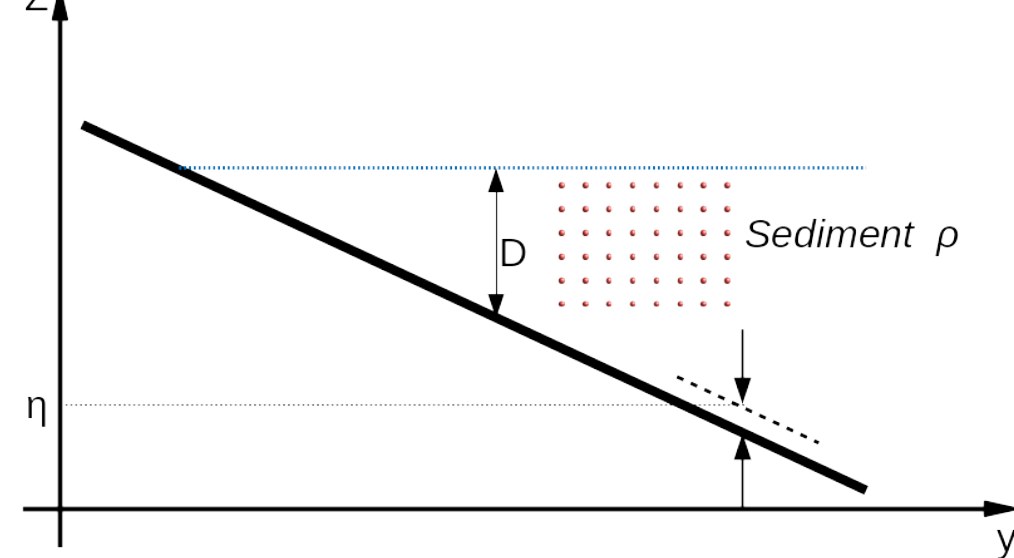
Figure 2. Schematic representation of the seabed geometry: ρ represents the sediment concentration in water; D represents the “closure depth”, i.e., the maximum depth at which the waves are able to generate sediment resuspension from the seabed; and η represents the seabed height, relative to a fixed